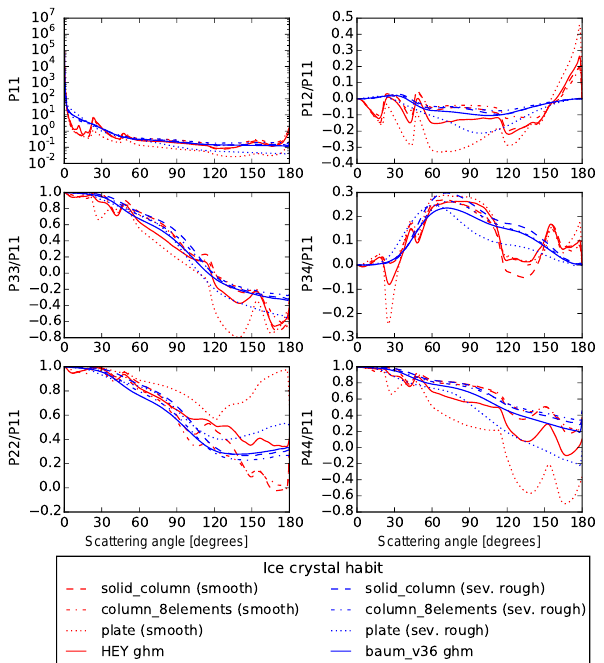
Figure 5. Phase matrix elements of ice crystal distributions with an effective radius of 40µm at 550nm wavelength. The red lines correspond to smooth and the blue lines to severely rough crystals. The individual habits ( solid-column , column-8elements and plate ) are for the parameterization yang2013 , and the gen- eral habit mixtures ( ghm ) are for hey including smooth crystals and baum_v36 including severely rough